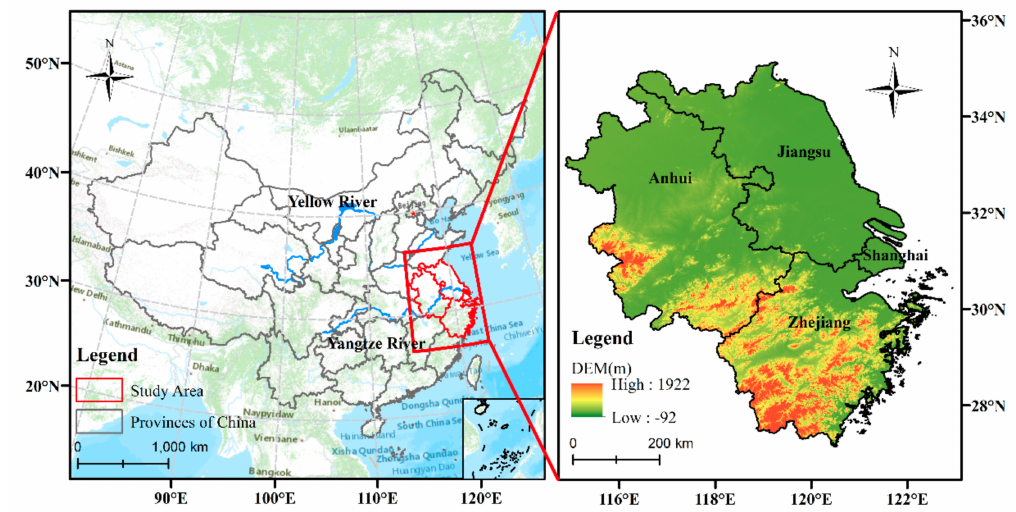
Figure 1. Location and topographic map of the study